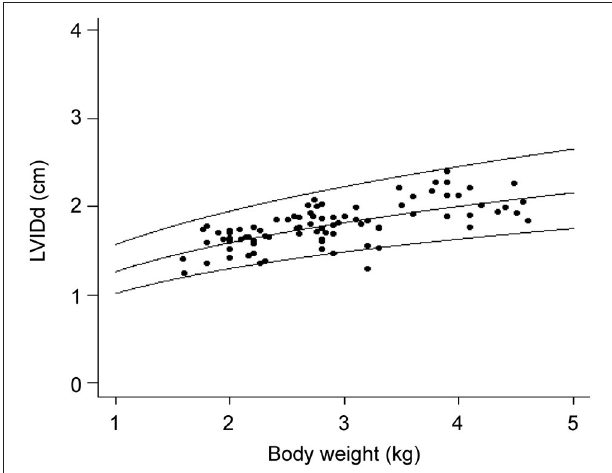
FIGURE 1 | Scatter plot of LVIDd and body weight with predicted values and 95% confidence intervals. LVIDd, Left ventricular end diastolic internal